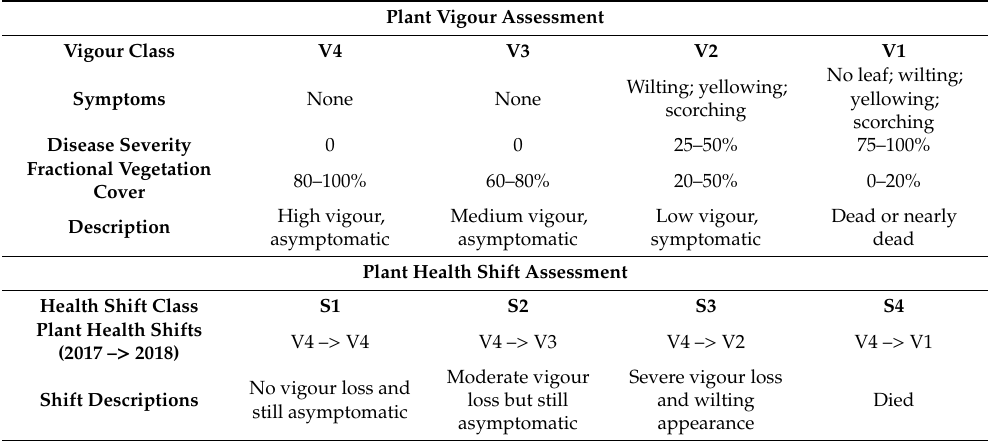
Table 2. Criteria used by experts to evaluate plant vigour and health shift classes. Plant vigour was estimated from RGB clips for 2017 and 2018 surveys. Plant health shifts between the two years were then derived only for plants that were highly vigorous (V4) in